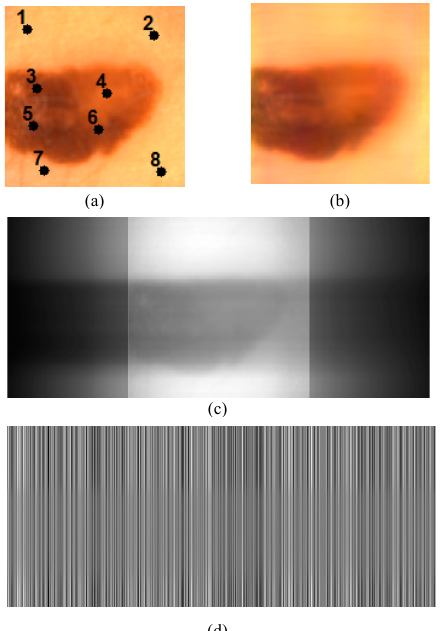
Figure 7. "Skin Tissue" with 30 spectral bands in the range of 460nm-850nm: (a) pseudo-color representation of the spectral cube measured with the VTT spectral imager; (b) pseudo-color representation of the reconstructed spectral cube; (c), (d) simulated dispersed and diffused image with and without Figure 9. Spectra at chosen pixels of reference (red) and Randomizer, respectively. reconstructed (dashed black) of the “Skin Tissue” with the 33 spectral bands in the range of 460nm-850nm. Position of pixels as in Figure